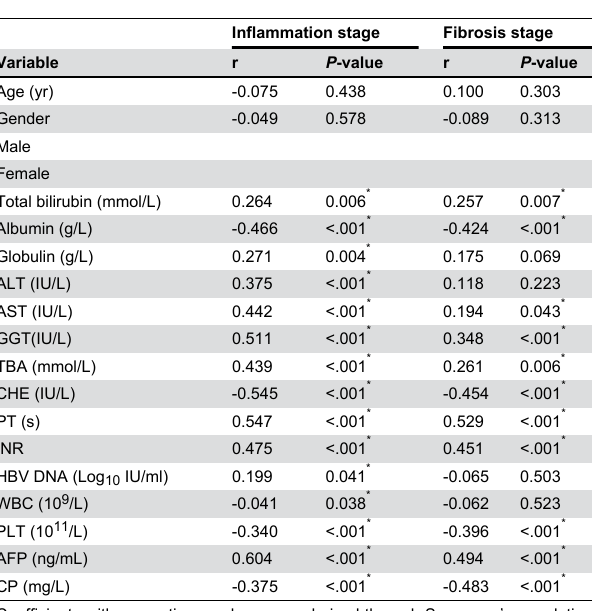
analysis or Kendall’s tau correlation